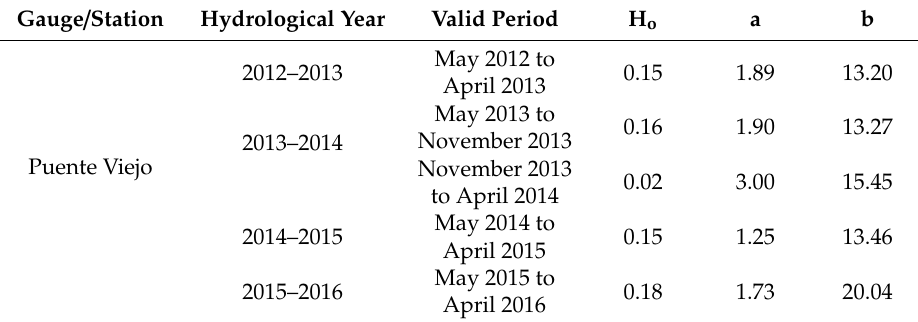
Table 2. Rating curve coe ffi cients for di ff erent hydrological years at Puente Viejo Station. Gauge / Station Hydrological Year Valid Period